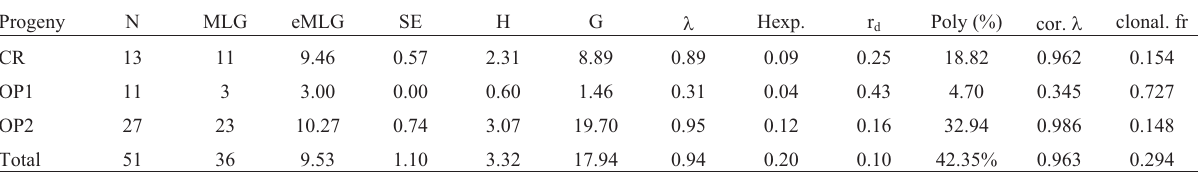
Table 4 - Analysis of multilocus genotypes diversity in progenies of Paspalum modestum.